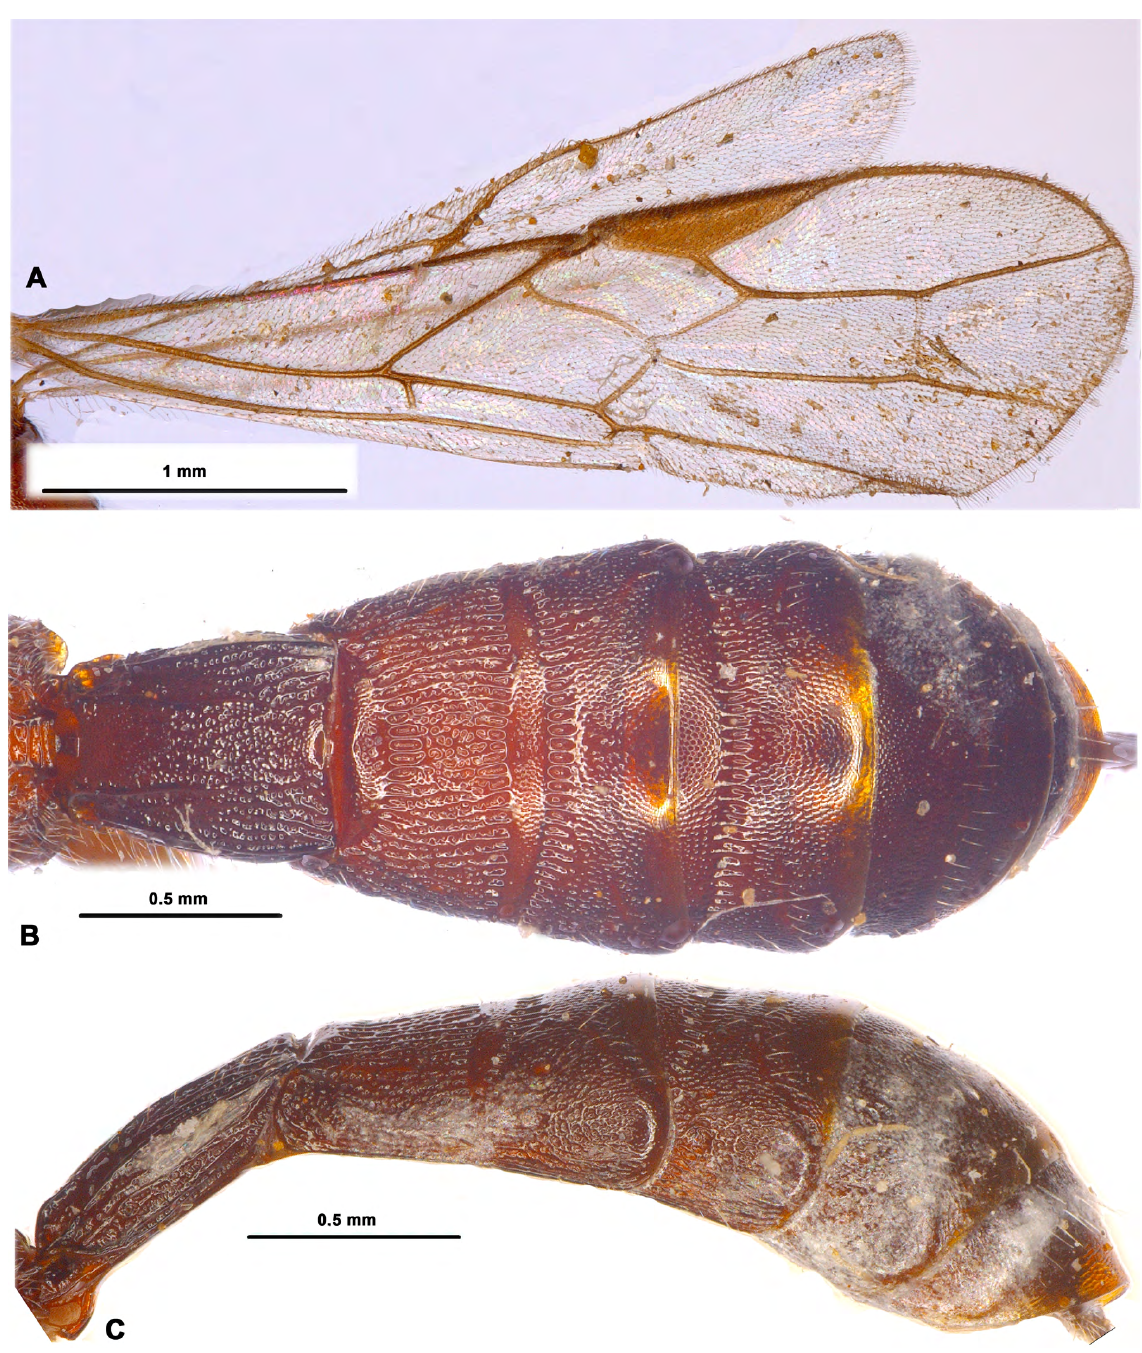
Fig. 15. Ipodoryctes anticestriatus (Granger, 1949), ♀, holotype, MNHN. A . Wings. B . Metasoma, dorsal view. C . Metasoma, lateral